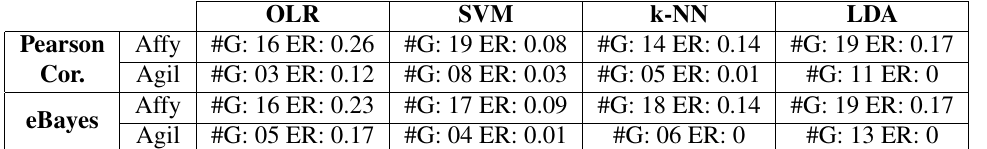
Table 5: Results for classifiers (columns), filtering methods (rows) at the gene level. #G - number of genes; ER - Error